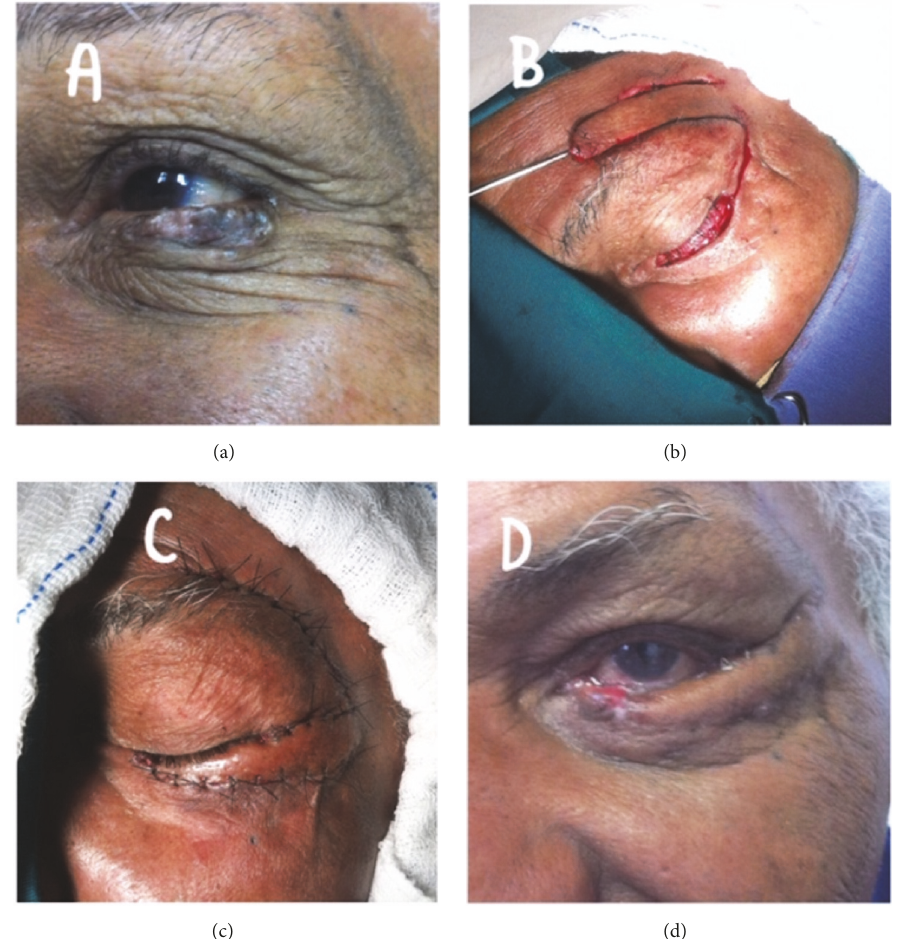
Figure 2: Lower eyelid BCC. (a) Aspect of the lesion. (b) Resection with margin and preparation of the eyebrow flap. (c) Immediate aspect. (d) Aspect with fifteen days of